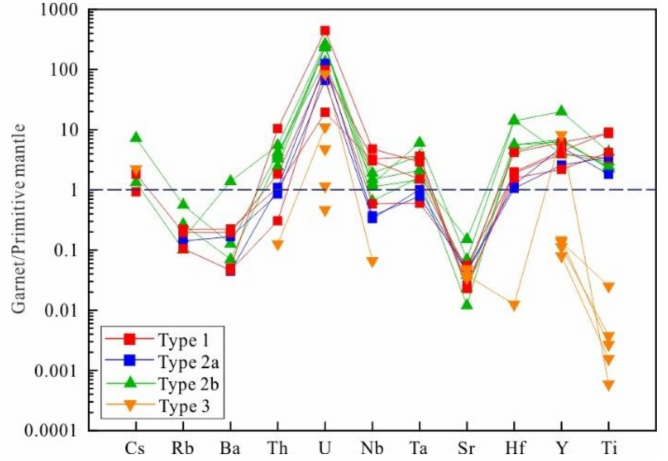
Figure 10. Primitive mantle-normalized multi-element diagram of garnets from the Laoshankou deposit. Normalization values are from [59].